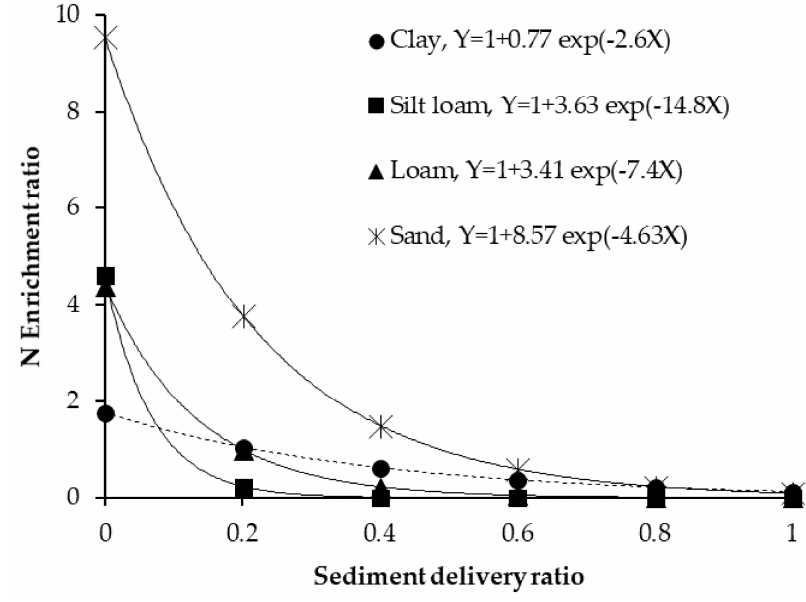
Figure 6. Relationship between sediment delivery ratio and enrichment ratio (adapted from [49,50]).